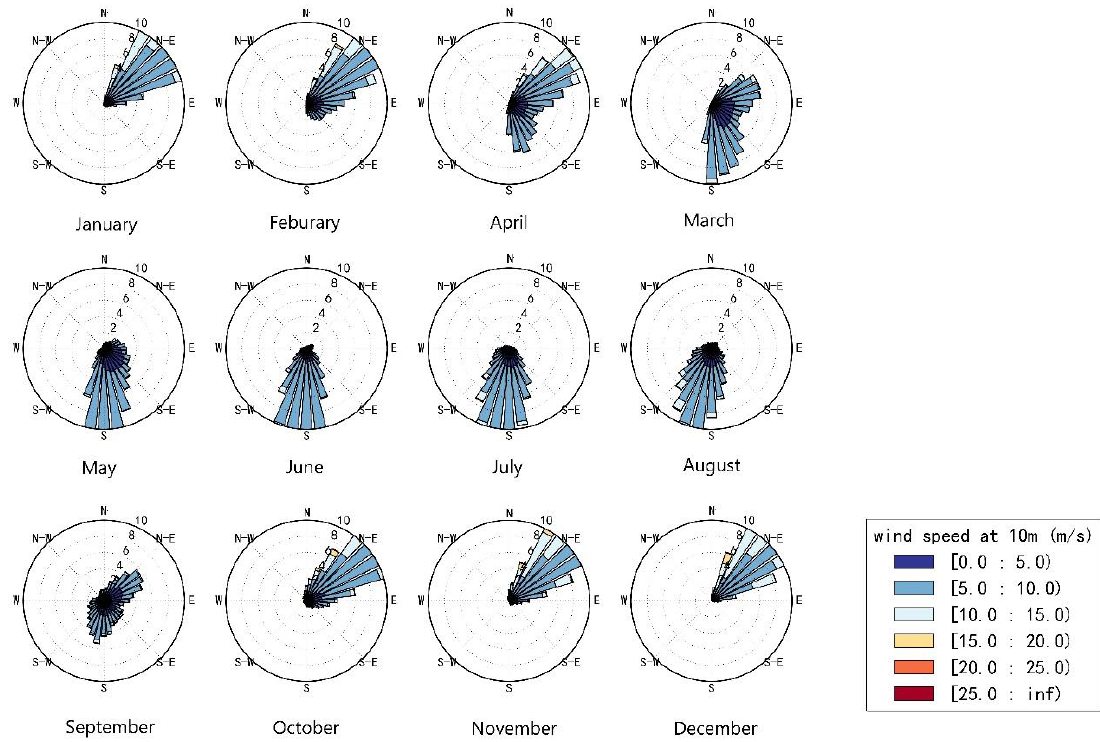
Figure 12. Monthly wind rose plots of wind speed at the Xisha Islands.